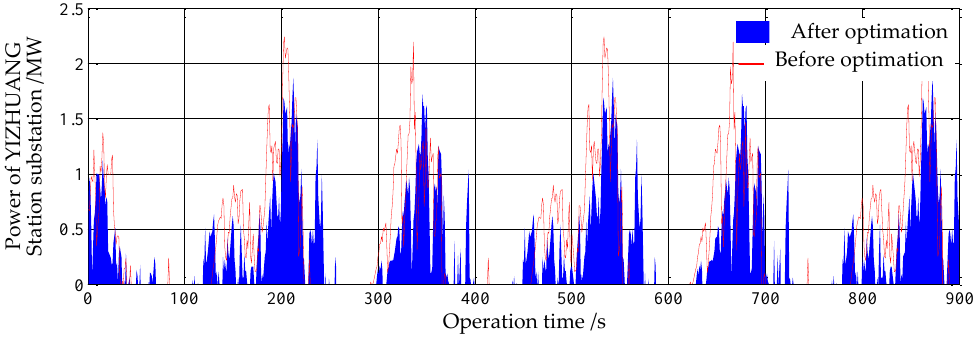
Figure 18. Power of Yizhuang Railway Station’s substation before and after dwell time optimization.